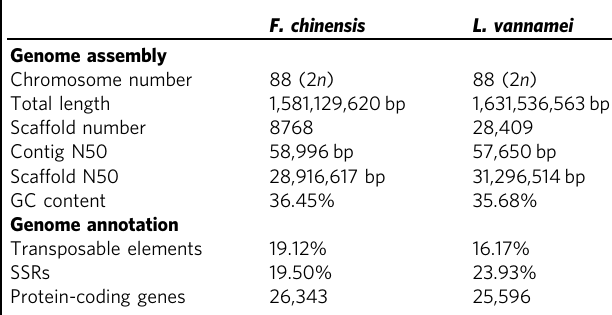
Table 1 Summary of two penaeid shrimp genome assemblies and